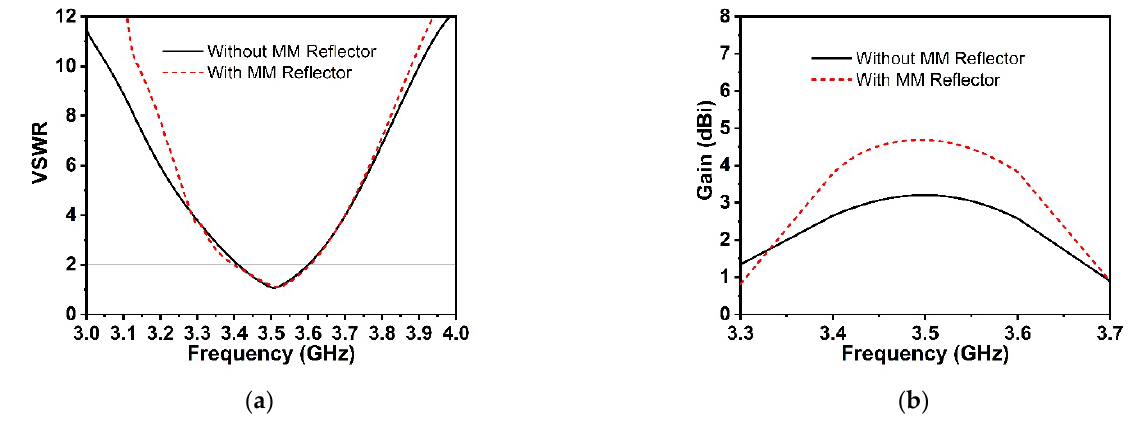
Figure 17. Comparison of the proposed antenna results with and without MM reflector. ( a ) VSWR. ( b ) Gain.